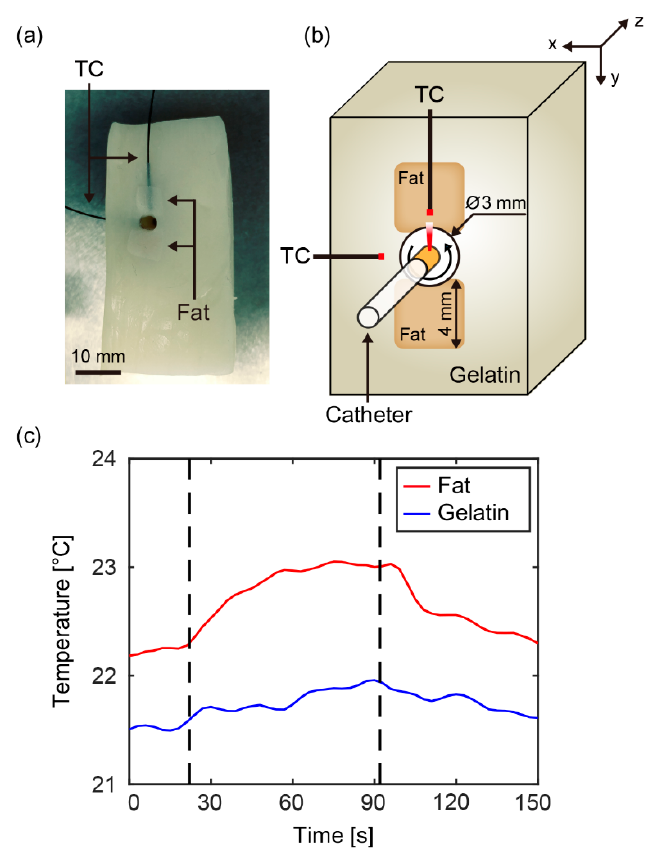
Figure 3. ( a ) A photograph of tissue-mimicking phantom. ( b ) A cross-sectional image of the catheter, phantom, and thermocouple at the image acquisition location. ( c ) A graph of temperature change of fat and gelatin, monitored by thermocouples. The laser was turned on at 22 s (a first dotted line), and off at 92 s (a second dotted line). TC, thermocouple.